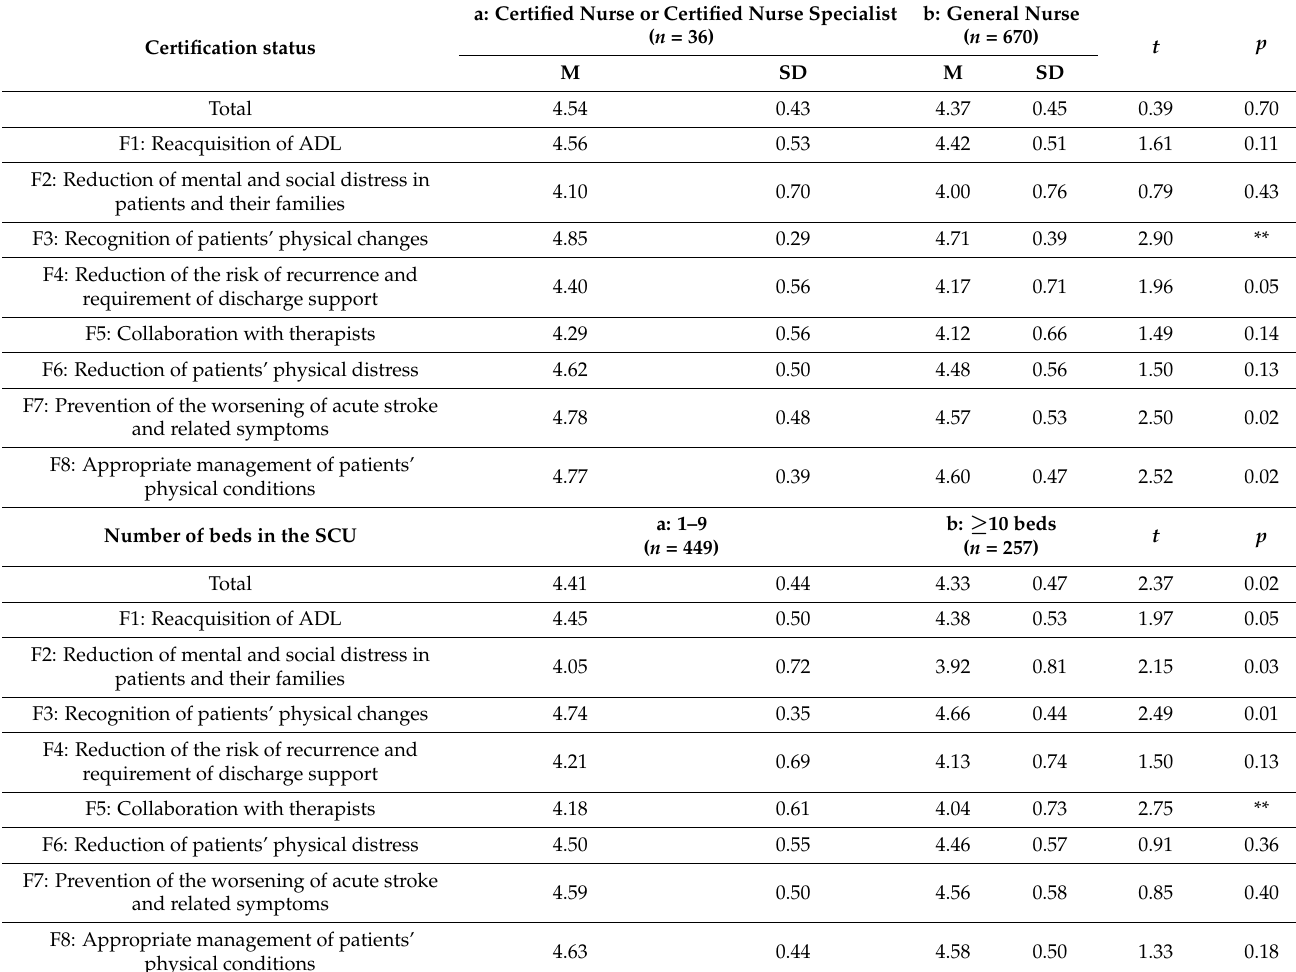
Table 4. Welch’s t -test between the two samples for actual